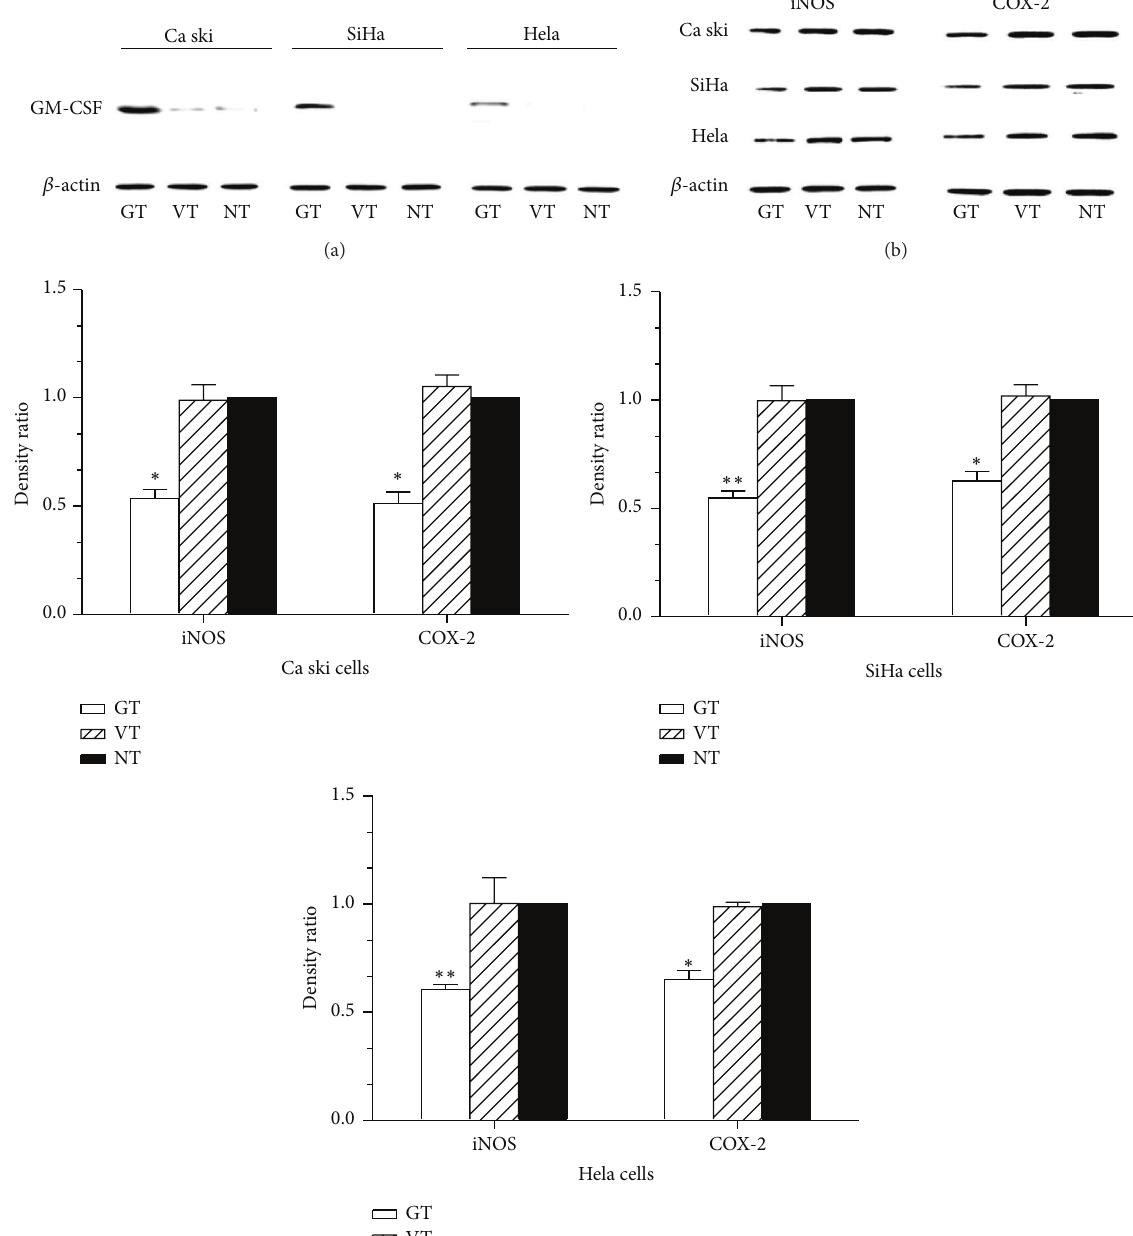
Figure 3: Overexpression of GM-CSF downregulated COX-2 and iNOS expression in cervical cancer cell lines. (a, b) Western blot analysis of Ca Ski, SiHa, and Hela cells untransfected or transfected with pGM-CSF or pcDNA3.1 to detect the expression of GM-CSF (a) and iNOS and COX-2 (b), respectively. (c) Unpaired Student’s 𝑡 -test was used to detect the differences of iNOS and COX-2 expression in different groups. Each experiment was repeated three times. GT: pGM-CSF transfected cells, VT: vector pcDNA3.1 transfected cells (vector control), and NT: nontreated cells (blank control). ∗ 𝑝 < 0.05 , ∗∗ 𝑝 < 0.01 versus NT group. Error bars represent mean ± SD.